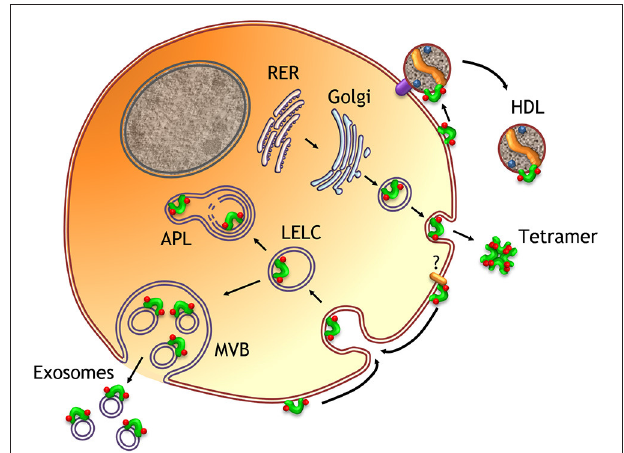
FIGURE 6 | Schematic representation of ApoD subcellular traffic. A model of an ApoD-expressing cell is represented. Canonical exocytosis through the RER-Golgi pathway generates the mature, glycosylated (red dots) protein. The tetrameric form identified in the breast cyst fluid is represented as the format detected in extracellular fluids. Once at the plasma membrane, ApoD can be endocytosed (by non-expressing cells as well) and targeted to lysosomes and autophagolysosomes. When endolysosomes develop into multivesicular bodies, ApoD would be carried on the outer surface of exosomes. Finally, ApoD can be transferred to HDL during their biogenesis, or during their lipid-efflux activity (upon HDL-receptor